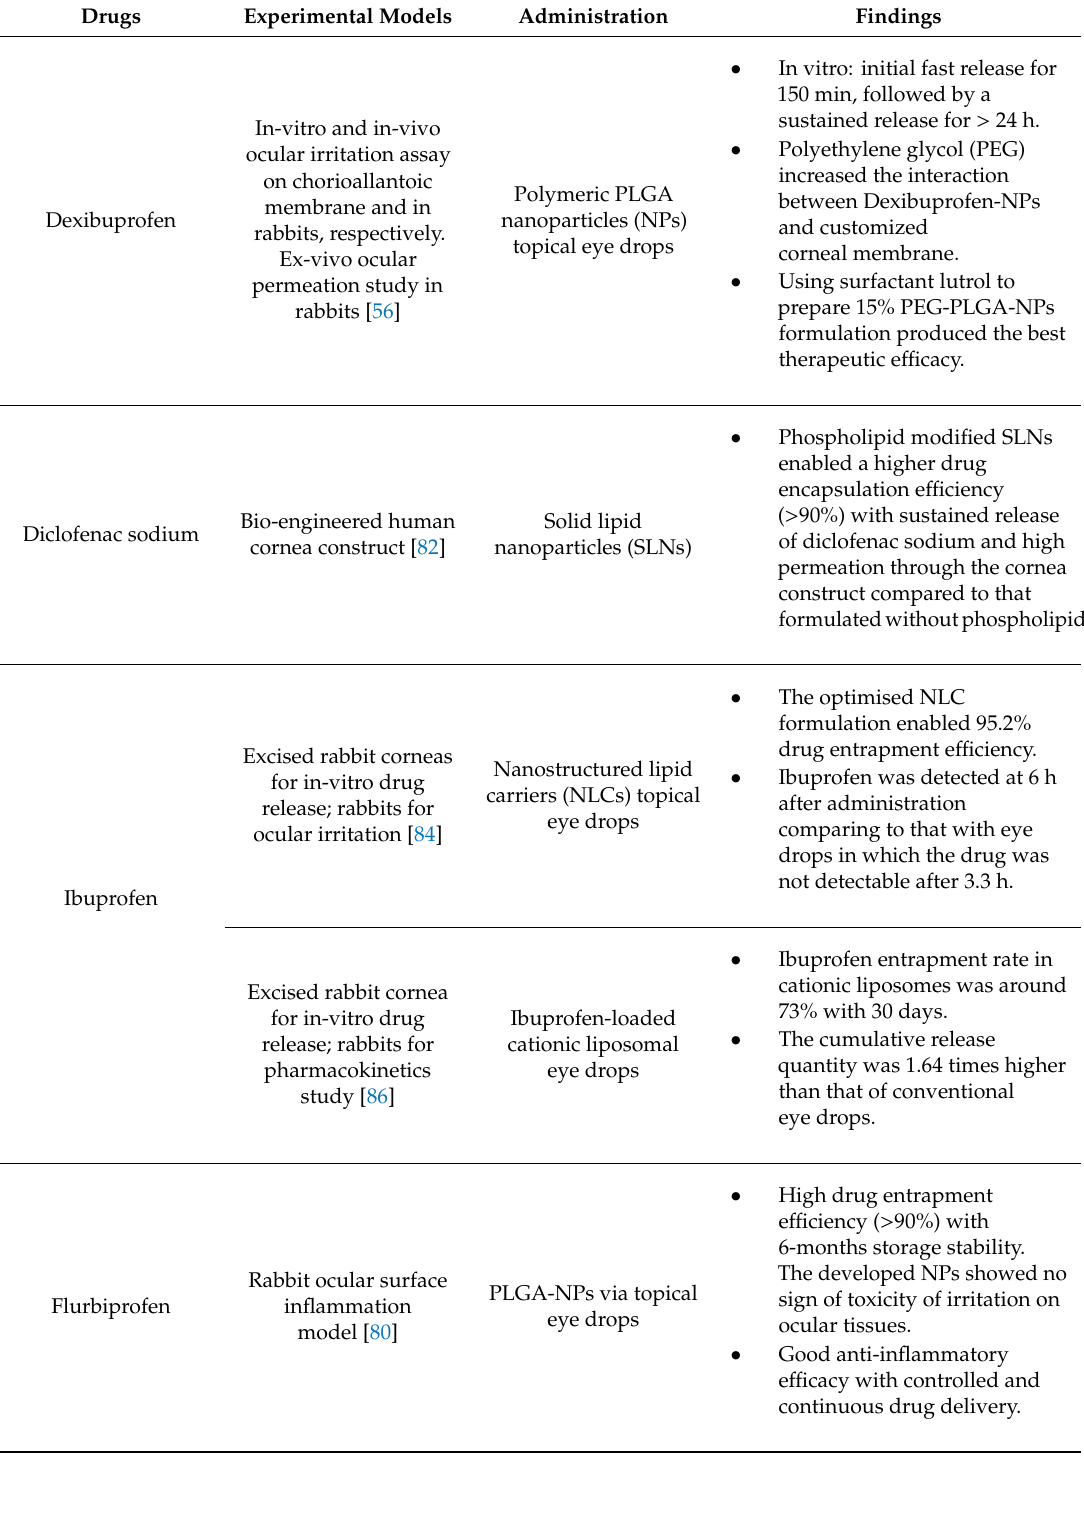
Table 4. Encapsulation of NSAIDs using nanotechnology-based drug delivery systems.